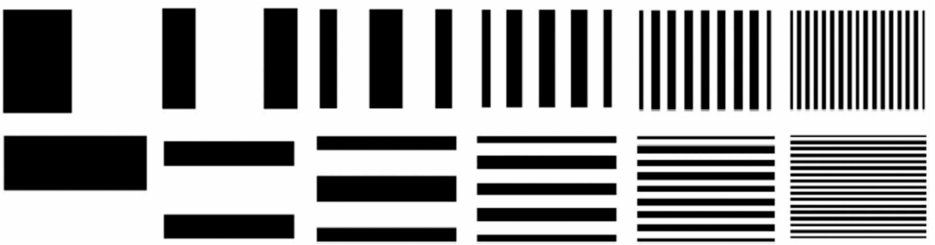
Figure 11. Generated gray-code patterns.